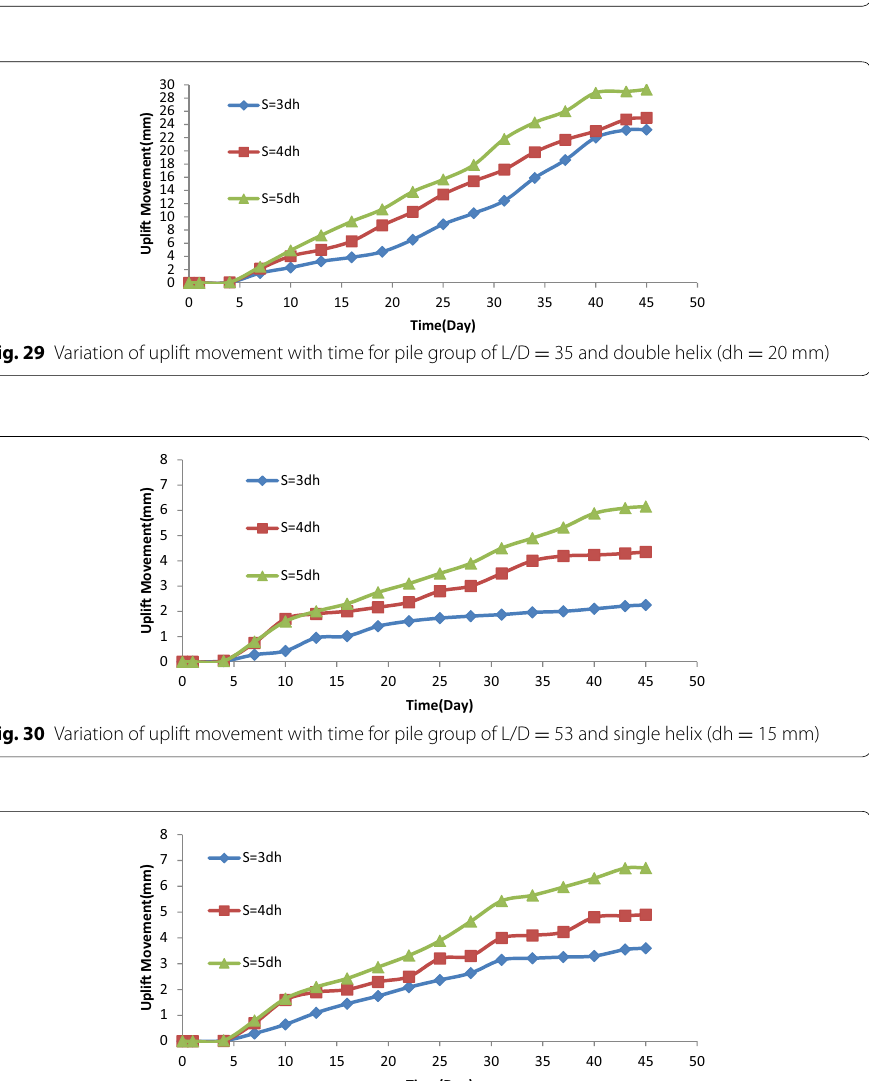
Fig. 28 Variation of uplift movement with time for pile group of L/D